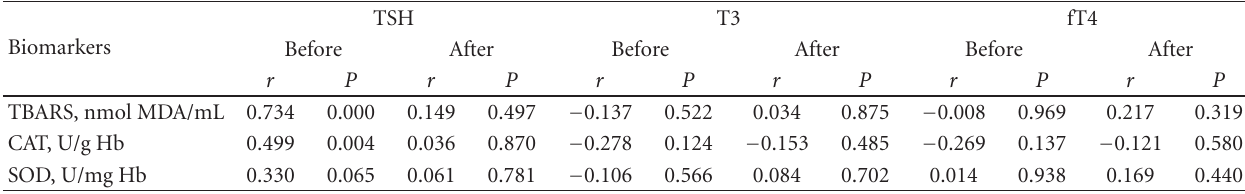
Table 3: Correlations of serums TSH, T3, and fT4 with oxidative stress biomarkers in the whole population before and after controlling for total cholesterol (TC) levels.